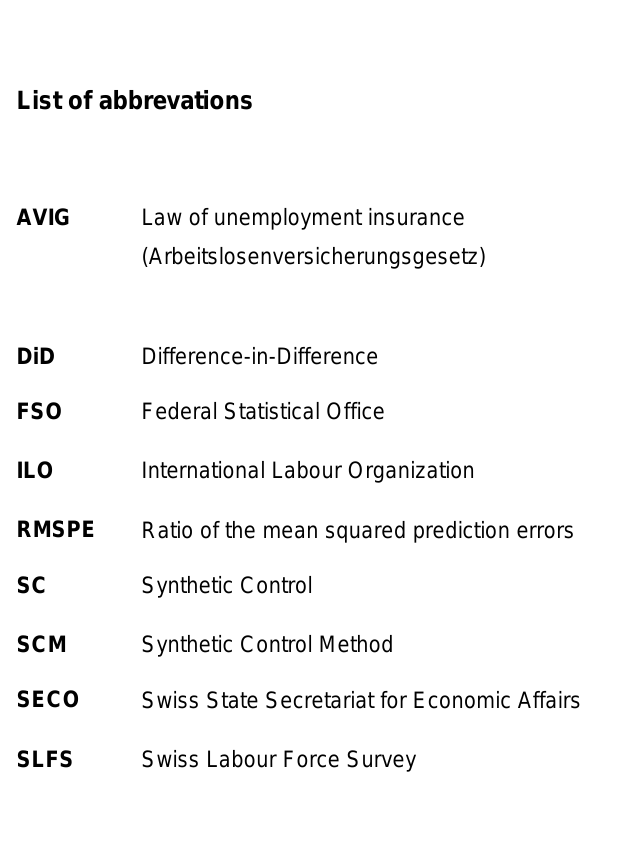
Figure 14. Outcome specification